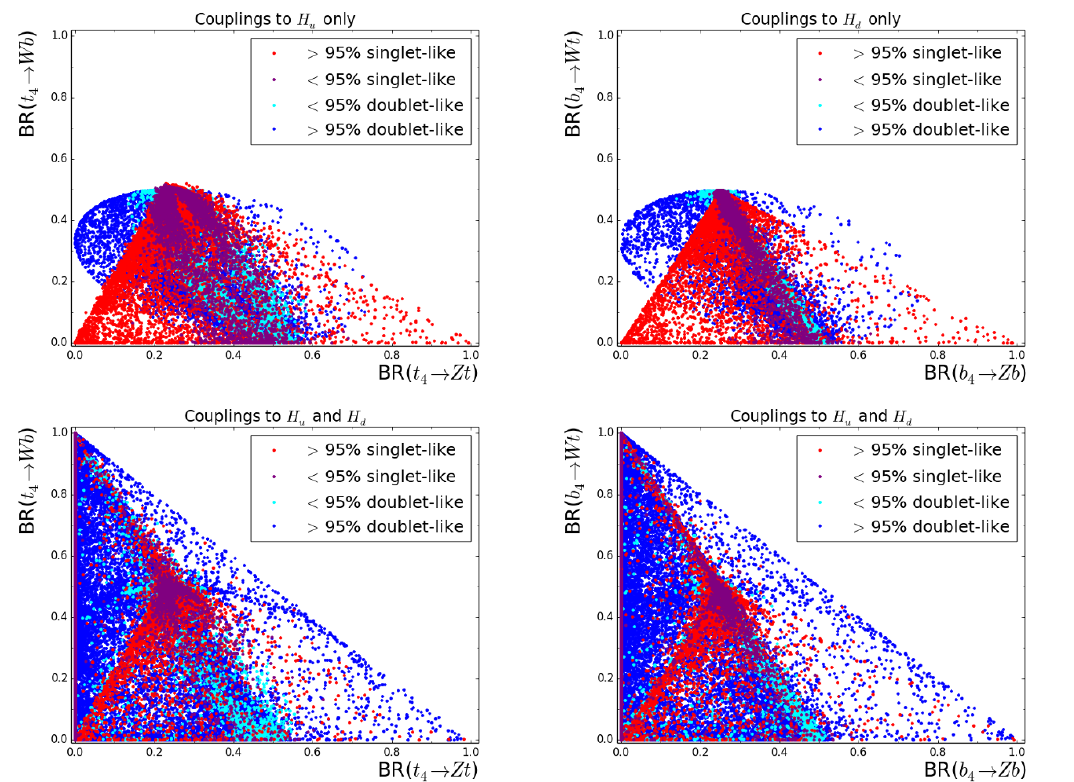
Figure 2 . The allowed branching ratios of the lightest vectorlike quarks in the scenario with couplings to H u only (top-left), couplings to H d only (top-right), and the general scenario (bottom panels). Red: 95% or more singlet-like, purple: 50%-95% singlet-like, cyan: 50%-95% doublet-like, blue: 95% or more doublet-like.